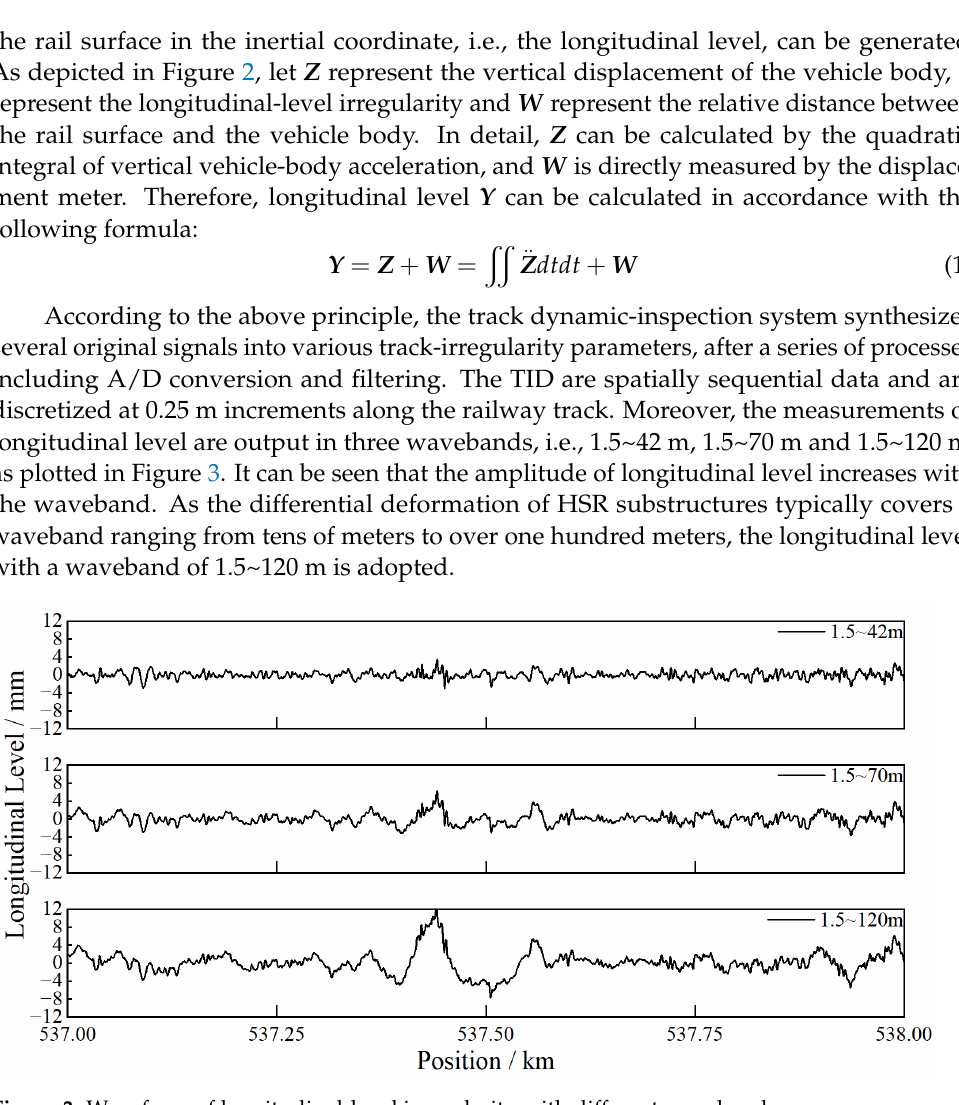
Figure 3. Waveform of longitudinal-level irregularity with different wavebands.